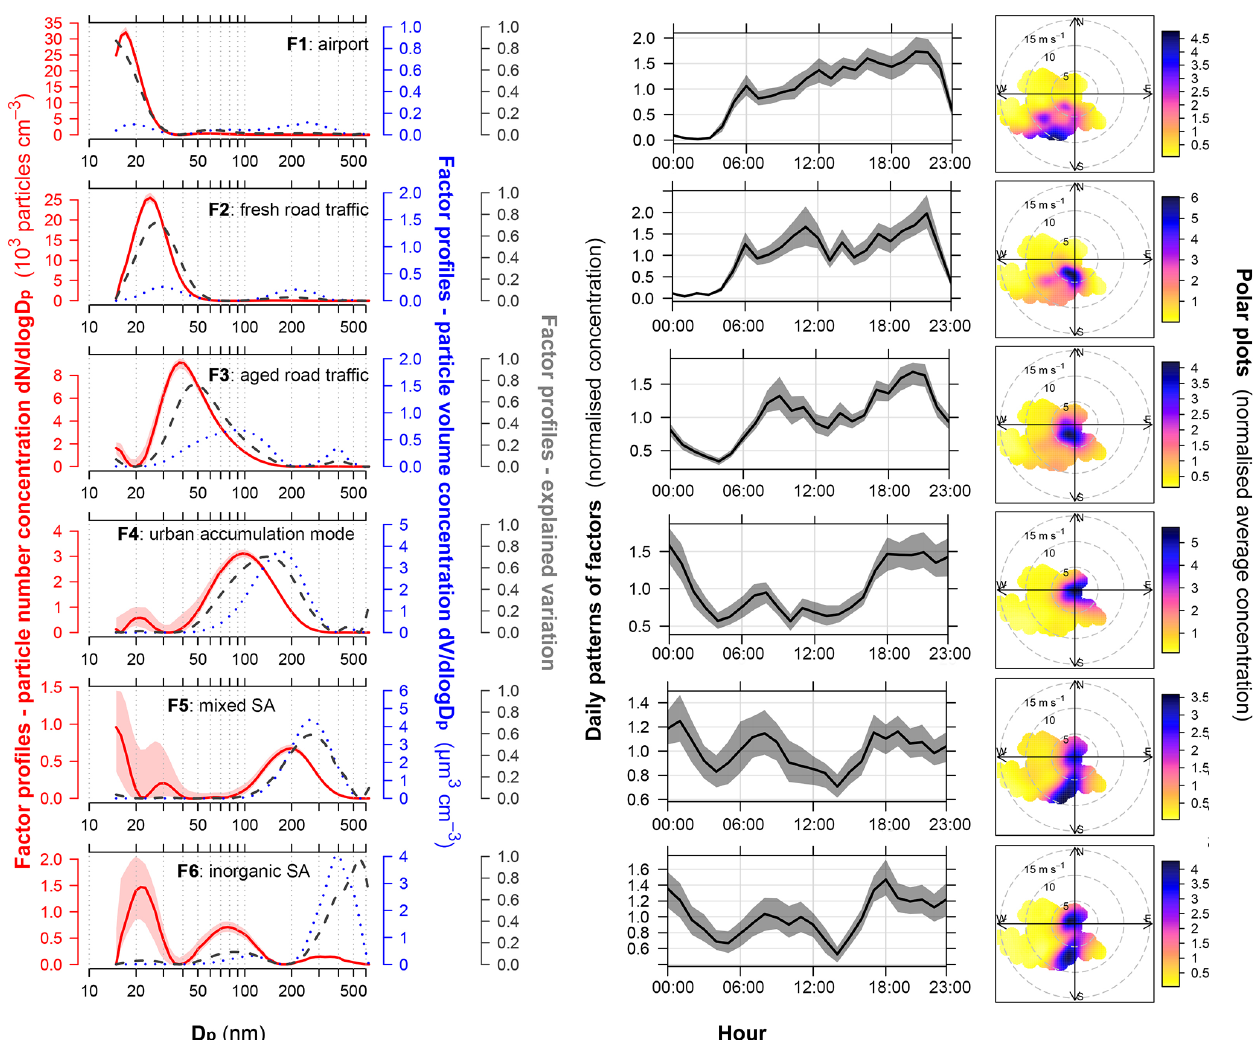
Figure 6. Results of PMF analysis for the cold season data. Factor profiles are reported on the left as (i) number concentration in solid red lines; (ii) their DISP ranges in shaded red areas, (iii) volume concentrations in dotted blue lines; (iv) explained variation in dashed grey lines. The plots in the centre report the normalised daily patterns calculated on the hourly-averaged factor contributions along with their 95th confidence intervals ( n = 200 bootstrap). The plots on the right show the polar plot analysis (normalised average factor contributions). SA: secondary